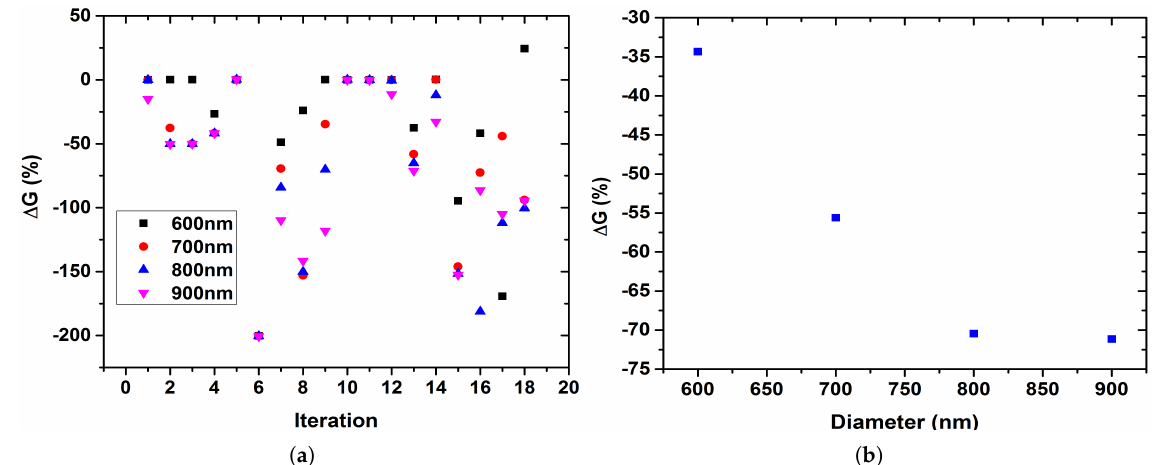
Figure 10. ( a ) Gradient magnetic field change from the case of 500 nm, ( b ) Overall percentage difference from the base case of 500